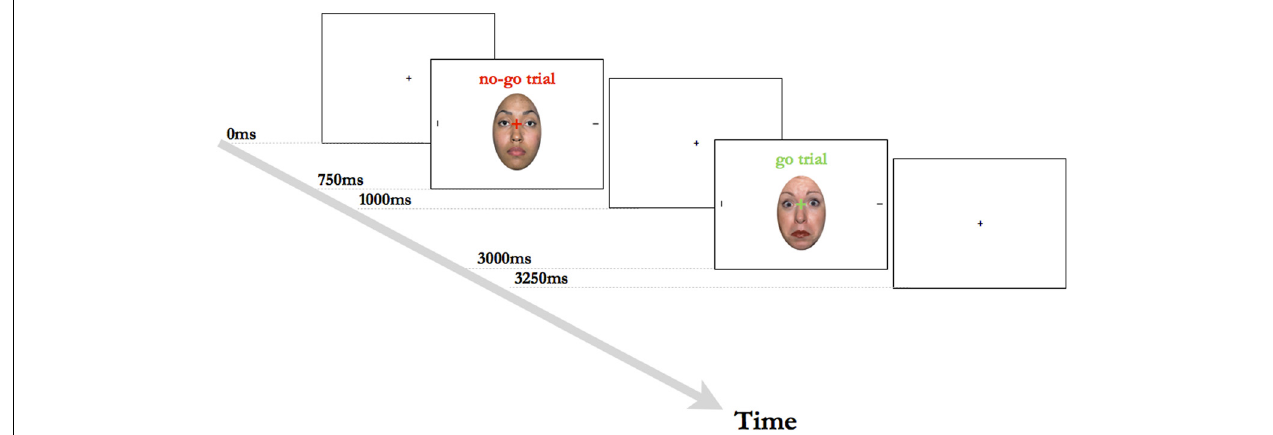
FIGURE 1 | Two example trials from the Overlap task. The central fixation cross was green on go trials or red on no-go trials. The horizontal target line was equally likely to occur on the left or the right side of the face, with the vertical line always appearing on the opposite side.